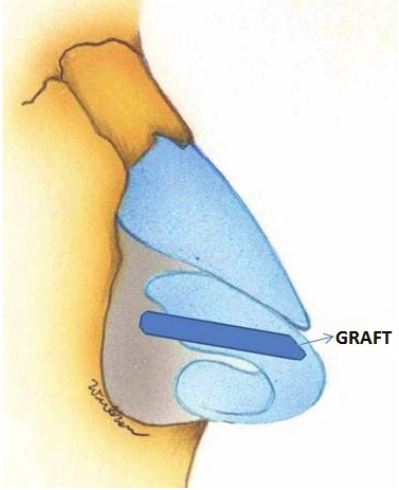
FIGURE 4 - The final aspect of the modified graft: it is completely beveled and it’s medial aspect is oblique. Observe its position parallel to the nostril’s